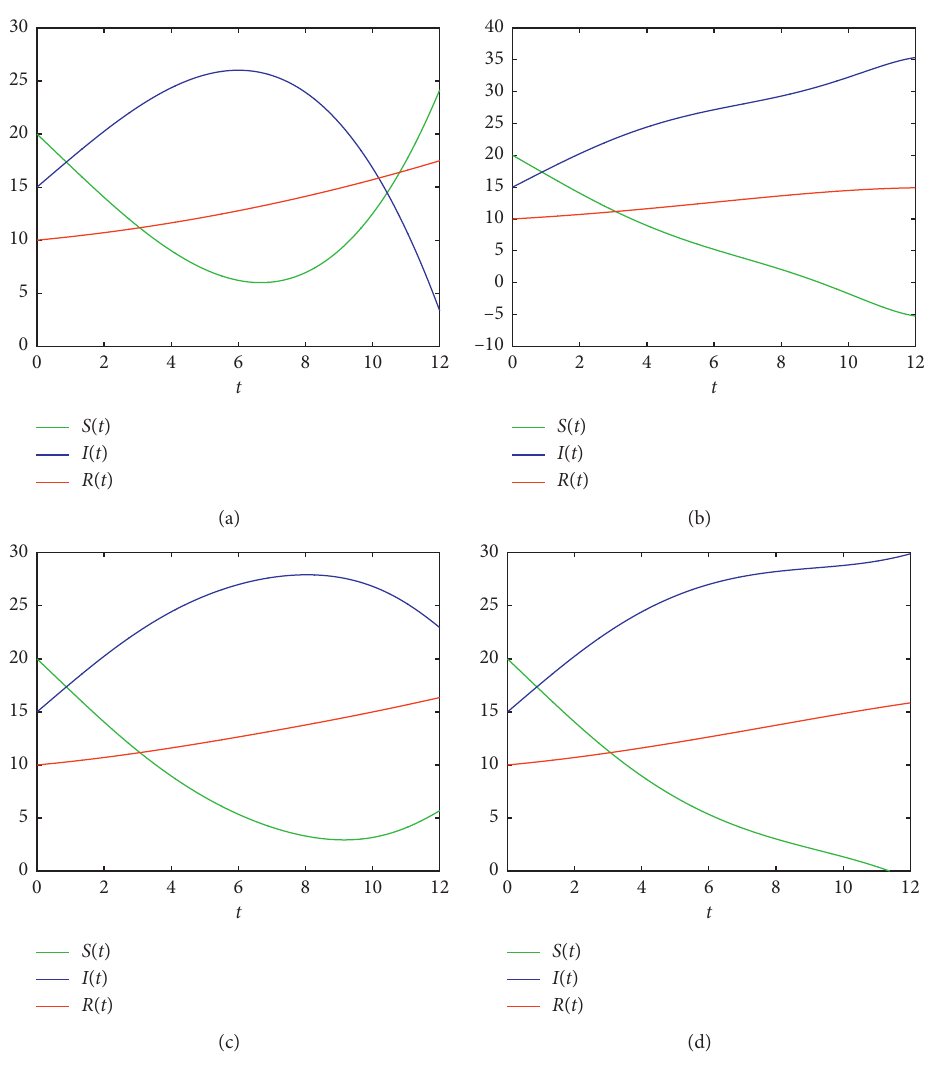
Figure 1: Three-, four-, five-, and six-term approximations for S ( t ), I ( t ), and R ( t ) versus time.